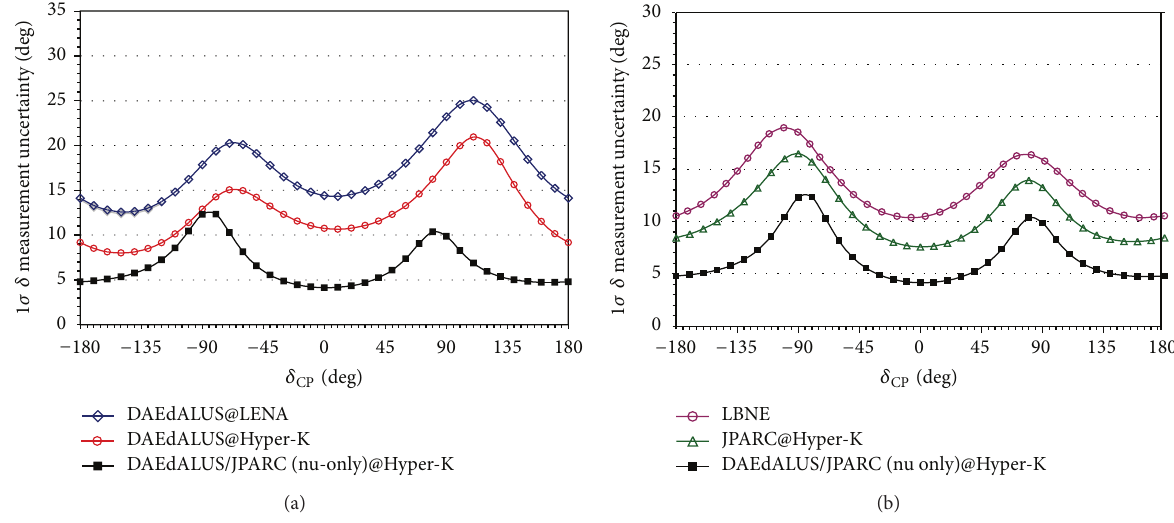
Figure 16: (a) The sensitivity of the CP violation search in various configurations assuming the normal mass hierarchy: dark blue:DAE 𝛿 ALUS@LENA, red:DAE 𝛿 ALUS@Hyper-K, and black:DAE 𝛿 ALUS/JPARC(nu-only)@Hyper-K. (b) pink:LBNE; green: JPARC@Hyper-K [26], and black:DAE 𝛿 ALUS/JPARC(nu-only)@Hyper-K (same as above). See Table 5 for the description of each